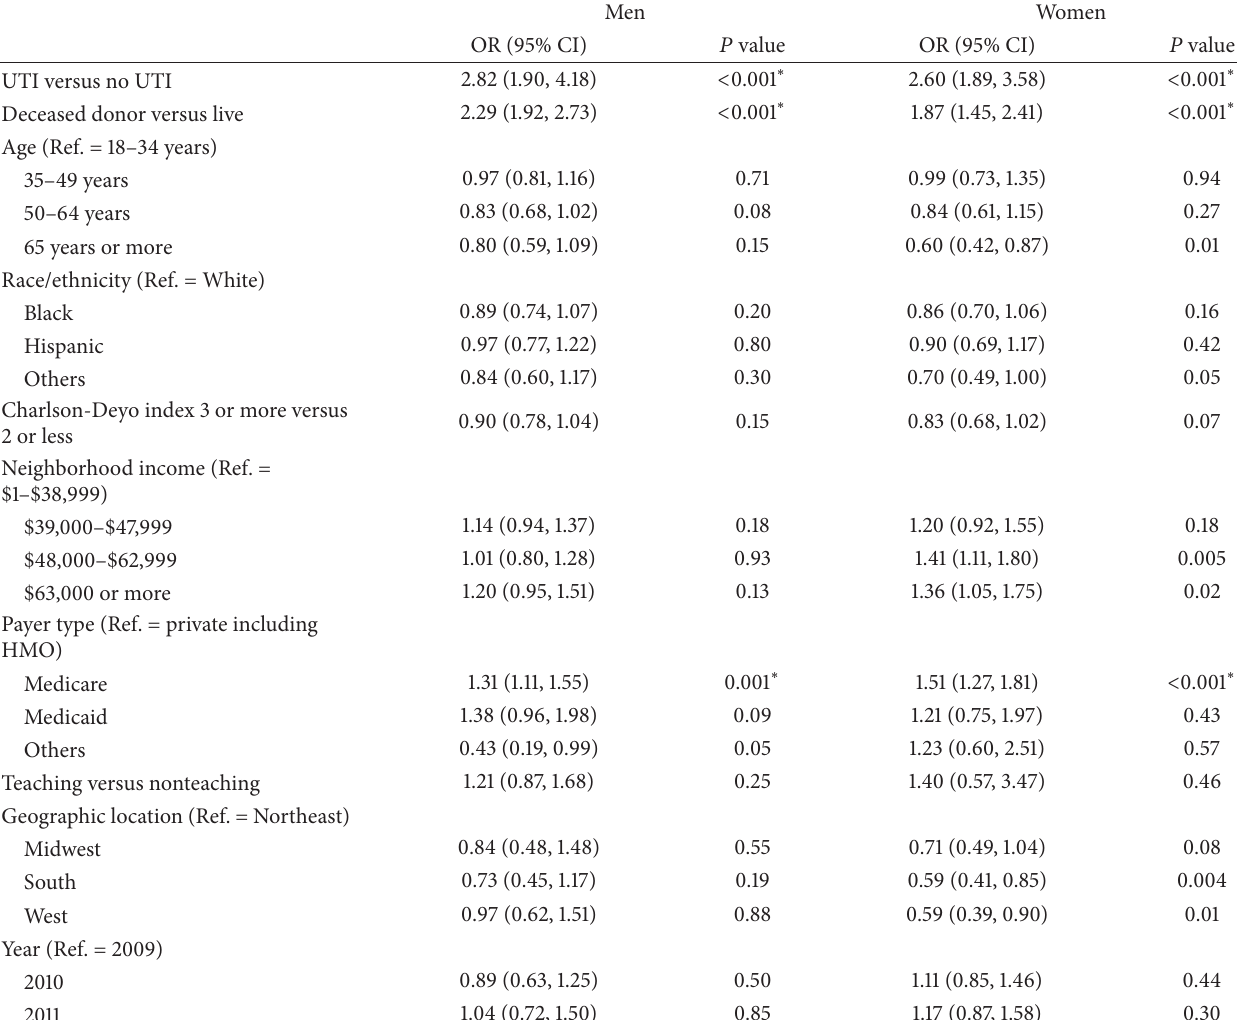
Table 2: Multivariable logistic regression odds ratio (and 95% CI) for complications of transplant among renal transplant recipients,